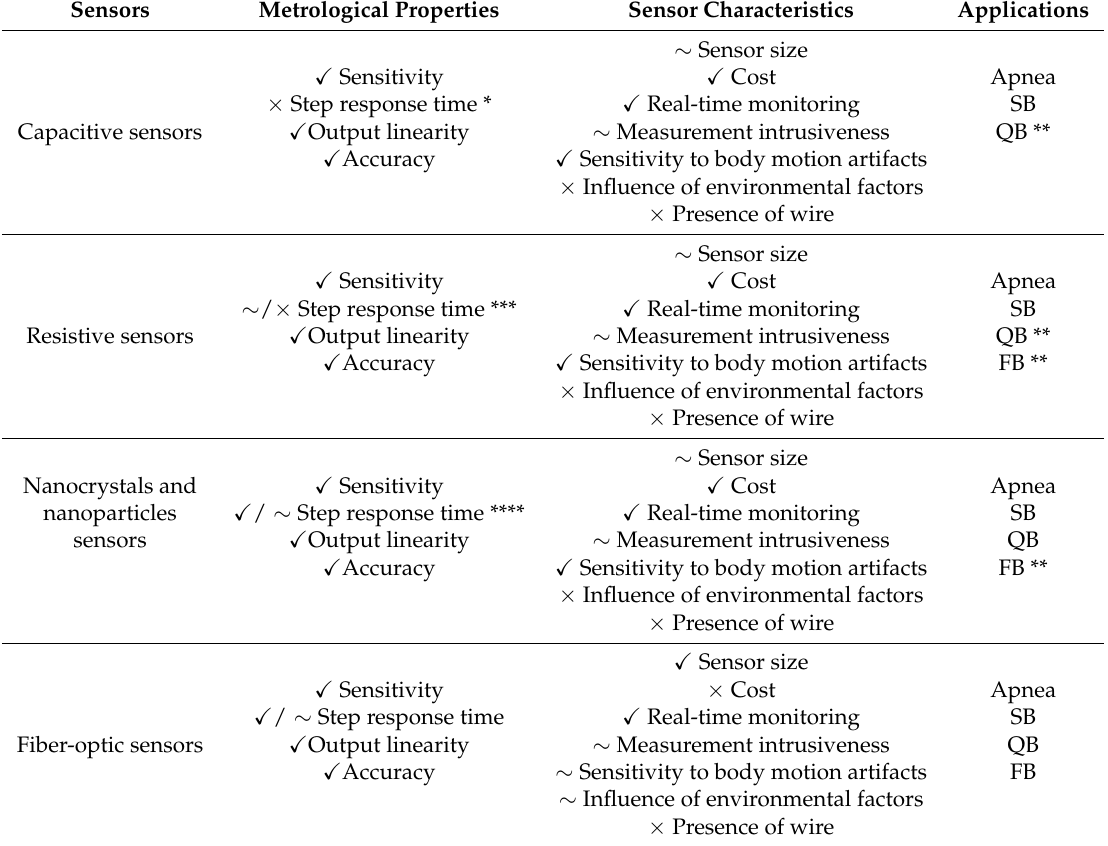
Table 4. Main metrological properties and characteristics of the humidity sensors used for f R measurement. (cid:88) good to excellent, ∼ sufficient, ×